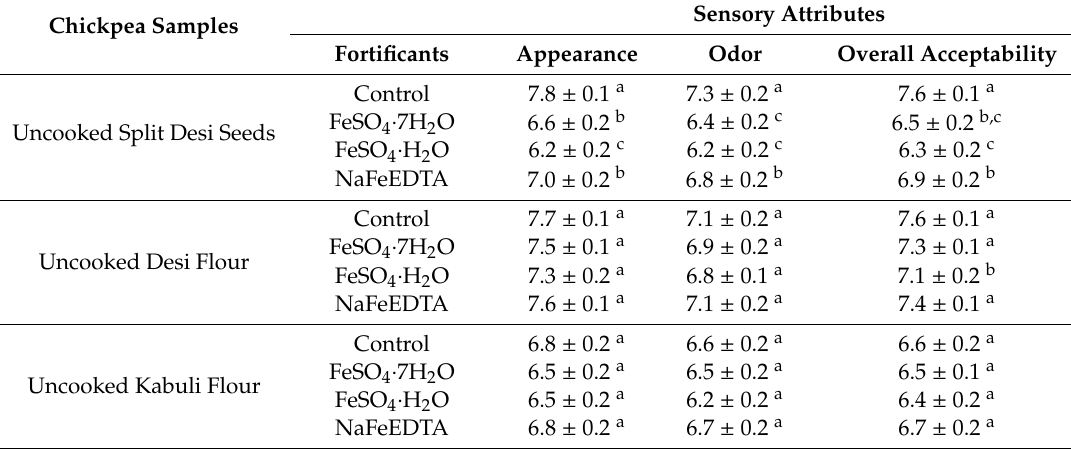
Table 3. Hedonic scale responses for three uncooked chickpea samples (split desi seed, desi flour